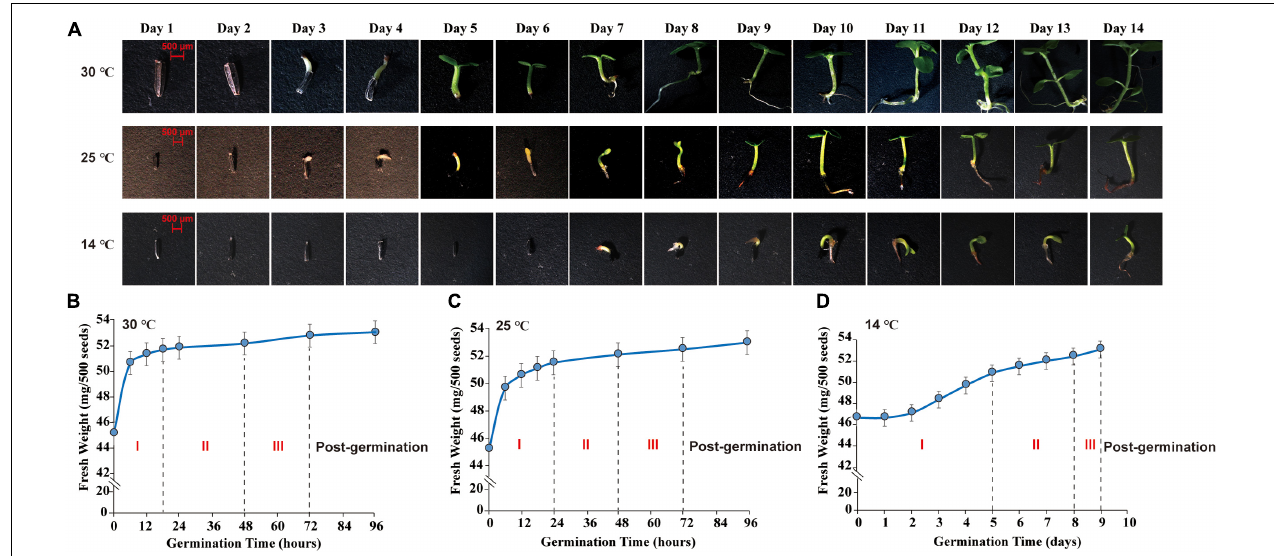
FIGURE 1 | Morphological observation and water absorption analysis of M. micrantha seed germination. (A) Effect of temperature on morphology of 2-week M. micrantha seedling. Time course of water absorption in germinating M. micrantha seed at 30 ◦ C (B) , 25 ◦ C (C) , and 14 ◦ C (D) .